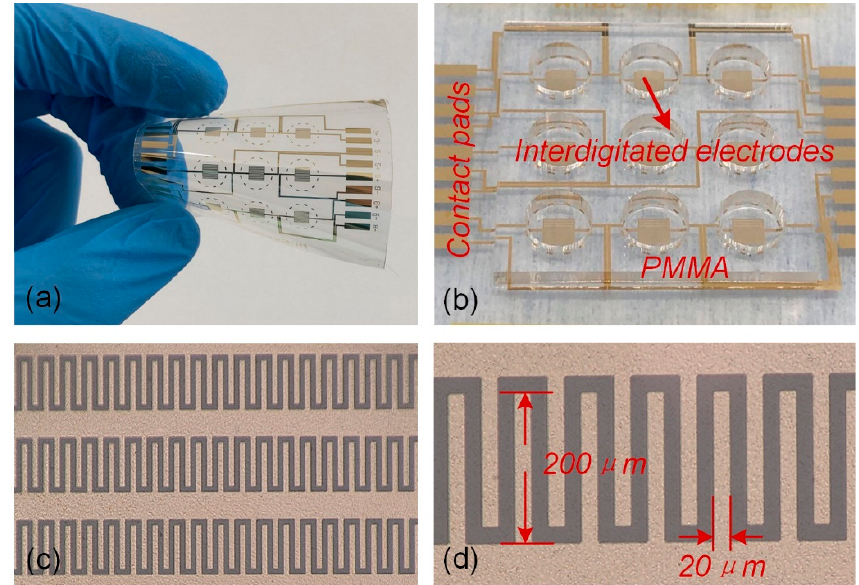
Figure 1. ( a ) Photographs of fabricating gold interdigitated electrodes on flexible PEN. ( b ) Physical picture of experimental test device; ( c , d ) Electrode local dimension diagram.